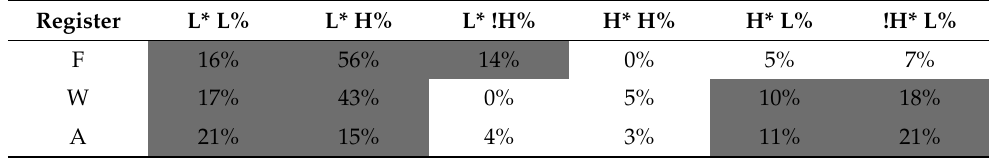
Table 5. Observed ‘simple’ nuclear contours, as a percentage of all turns in that